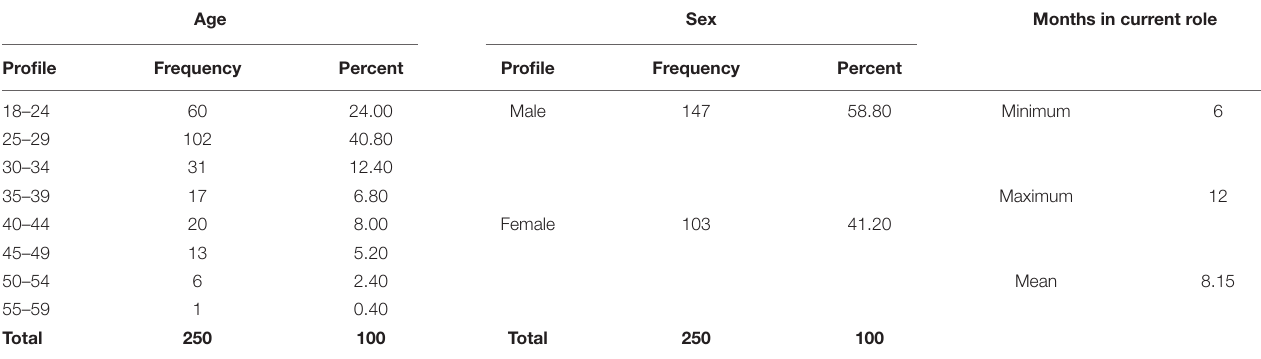
TABLE 1 | Demographic characteristics (study 1).